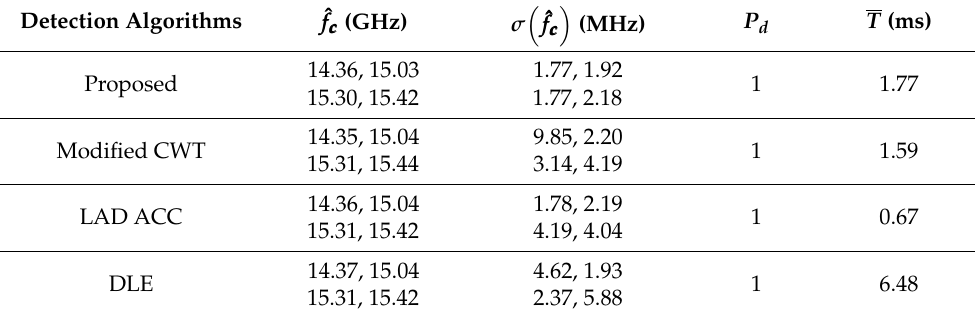
Figure 17. Detected sub-bands of the Starlink satellite. Table 4. Overall detection performance of different